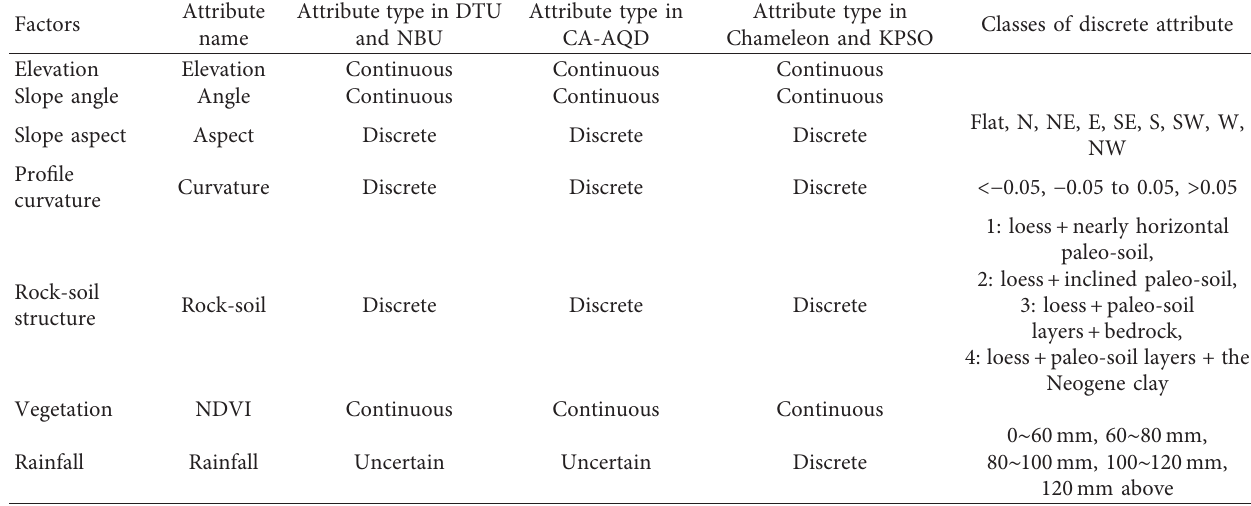
Table 2: The attribute type in different algorithms for constructing and evaluating landslide susceptibility mapping in the study area.